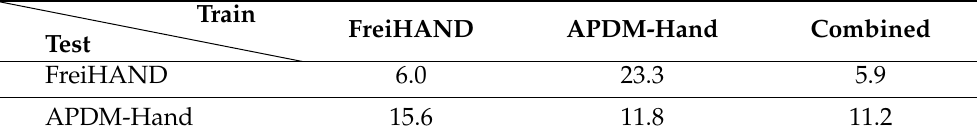
Table 8. 3D HPE results in terms of PA-MPJPE under the cross-dataset